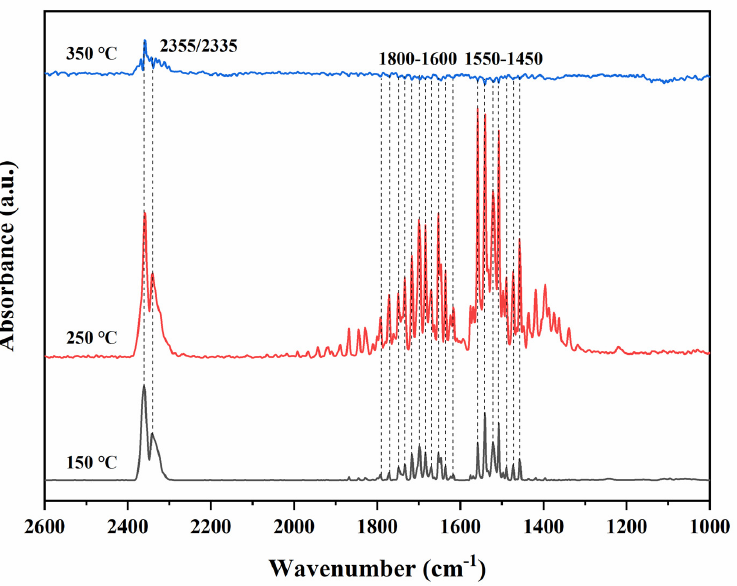
Figure 13. In situ DRIFTS spectra of the 5Ni/OMS-2 sample in a 2000 ppm toluene/O 2 /N 2 feed gas at different temperatures.